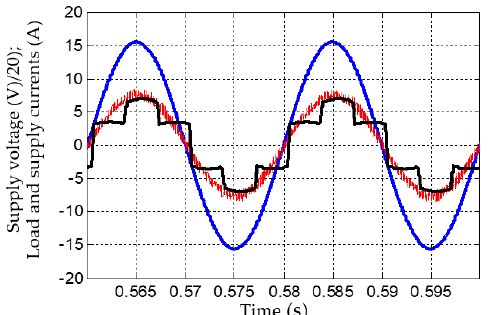
Figure 12. Waveforms of load current (in black), supply voltage (in blue) and supply current (in red), in steady-state regime at reduced load.